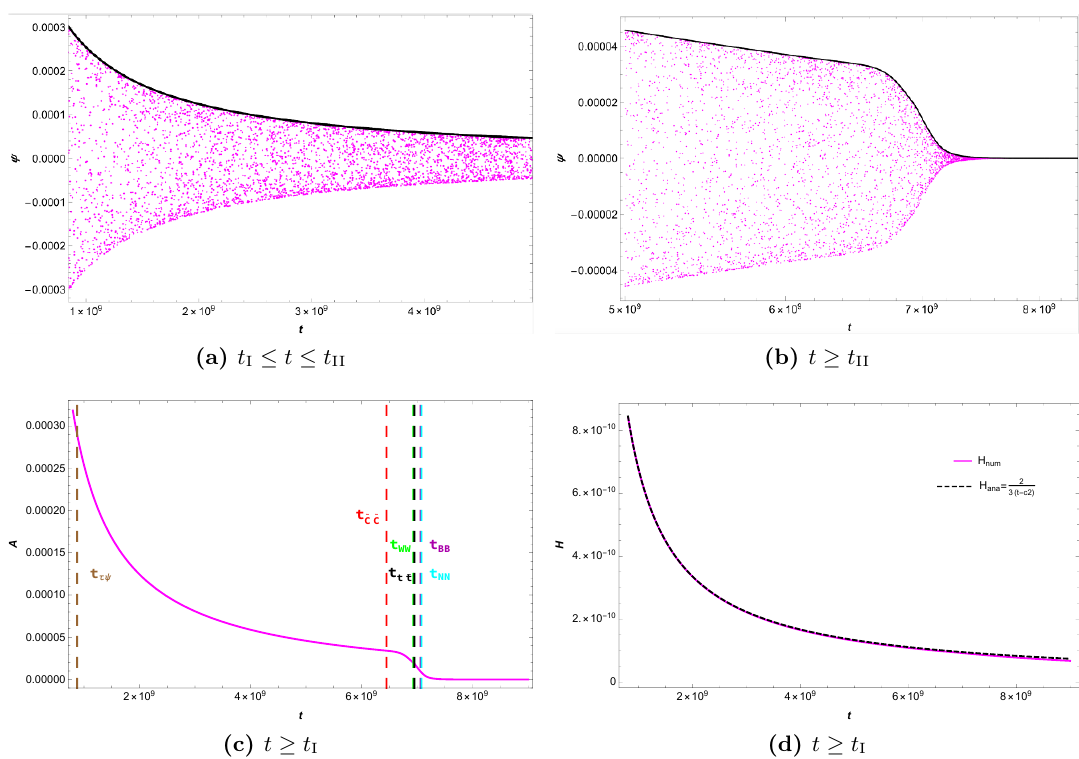
Figure 13. In both (a) and (b), the 5000 magenta points are randomly chosen from the curve of the output ( t ), in the last ( n th) round of iteration, during the time intervals t I (cid:20) t (cid:20) t II and t (cid:21) t II respectively. Their upper boundaries are identical to the input A ( t ) in the last round of iteration, that is, A n , which is the black curves in (a) and (b). In (c), we plot the upper boundaries of the magenta points, that is, A n +1 , from t I to sometime after reheating. In addition, the time at which each specie is turned on is marked with a vertical line, where t (cid:28) (cid:3) = 8 : 78 (cid:2) 10 8 , t ~ = 6 : 45 (cid:2) 10 9 , C ~ C (cid:3) t WW (cid:3) = 6 : 93 (cid:2) 10 9 , t = 6 : 95 (cid:2) 10 9 , t BB (cid:3) = 7 : 06 (cid:2) 10 9 and t NN (cid:3) = 7 : 08 (cid:2) 10 9 . In (d), we plot the t (cid:22) t (cid:3) solution for H in the last round of iteration, that is, H num , and also (4.26) as a reference, from t I to sometime after reheating. We always set t I = 8 (cid:2) 10 8 and t II = 5 (cid:2) 10 9 in our numerical calculations for technical convenience and everywhere set M P =